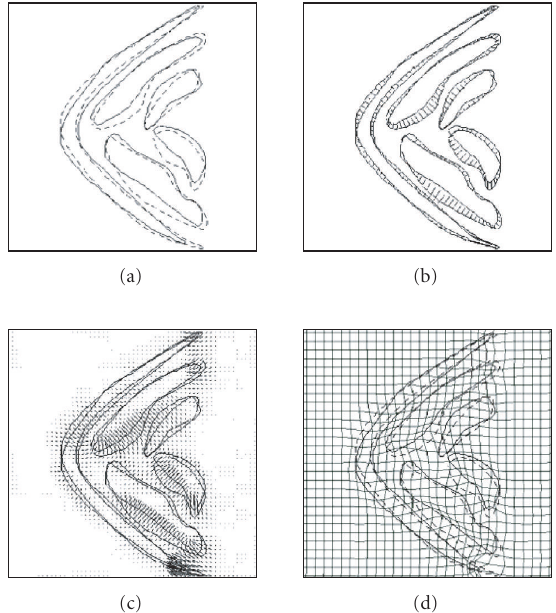
Figure 2: A simulation result deformation recovered by the de- formable sheet-curve model: (a) curve features, (b) recovered boundary deformation, (c) recovered image deformation, and (d) recovered image deformation in mesh